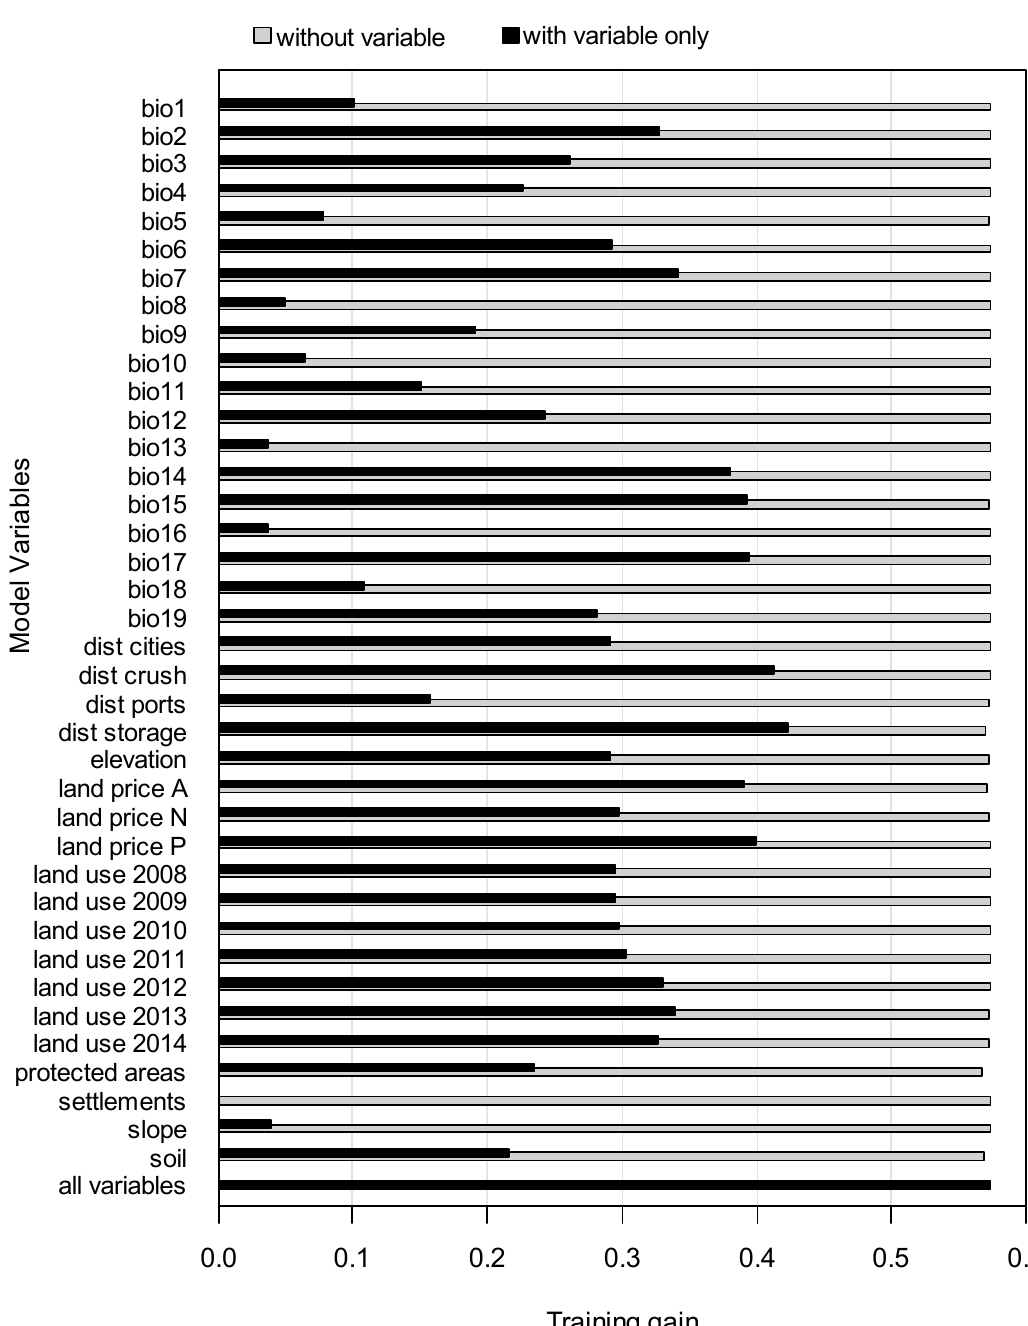
Figure 2. Results from the Jackknife sensitivity test. Training gains represent the relative contribution of each variable to explain the location of soy occurrence in the Legal Amazon in 2014 (see Table 1 for interpretation of the variable names).